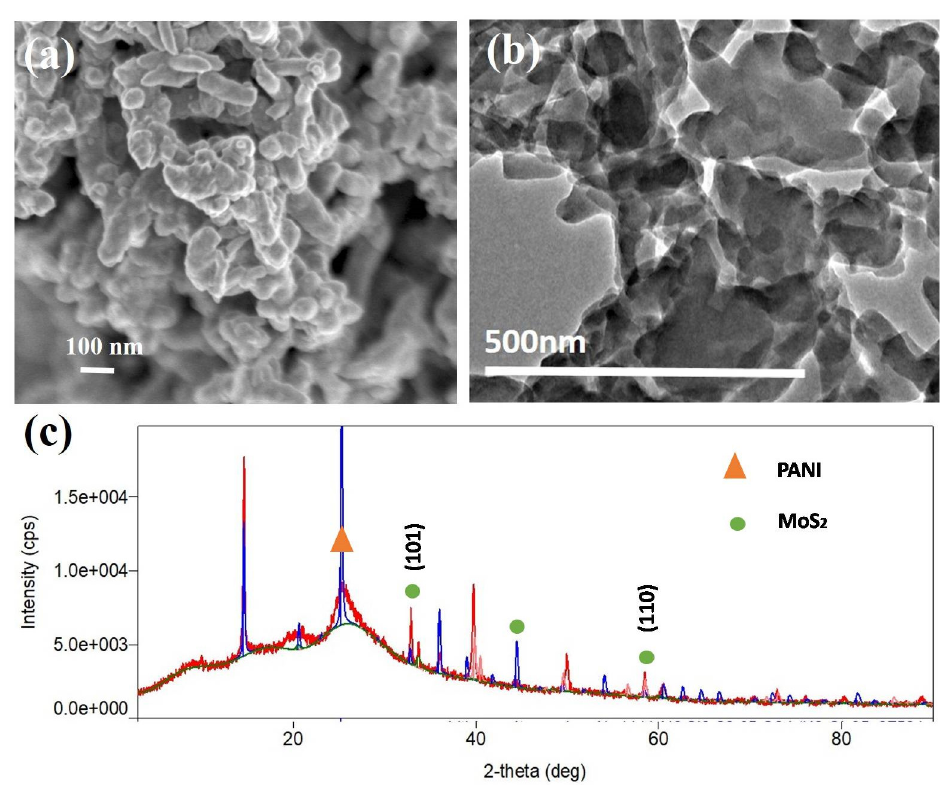
Figure 2. ( a ) SEM micrograph of PANI-7wt%MoS 2 , ( b ) TEM micrograph of PANI-7wt%MoS 2 , and ( c ) XRD pattern of PANI-7wt%MoS 2 (JCPDS NO. 00-032-0671 (MoS 2 )).